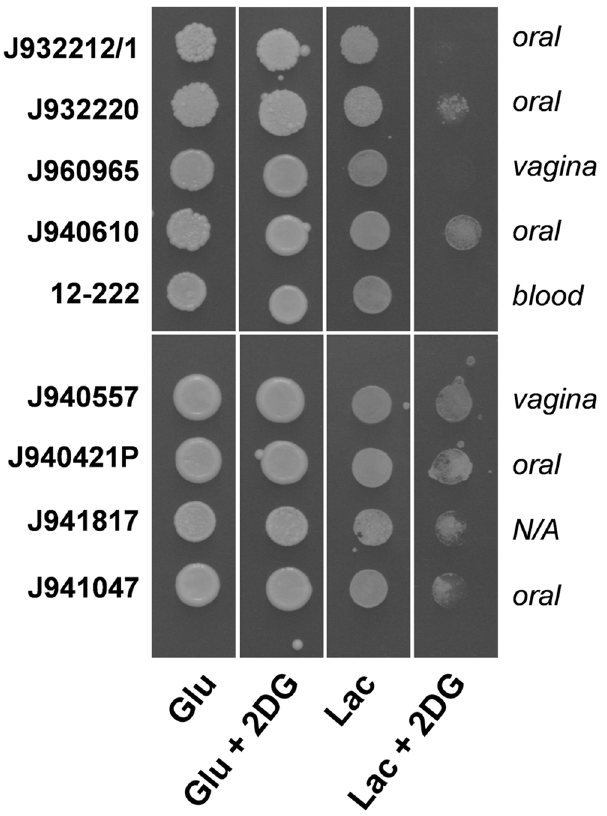
Fig 7. Many S . cerevisiae clinical isolates are Crabtree negative. S . cerevisiae clinical isolates were pre- grown in YNB-lactate and spotted on SC medium with glucose or lactate in the presence or absence of 200 μ g/mL 2-deoxyglucose. Nine clinical isolates are presented here, with data for a further 12 isolates presented in S4 Fig in the supplementary